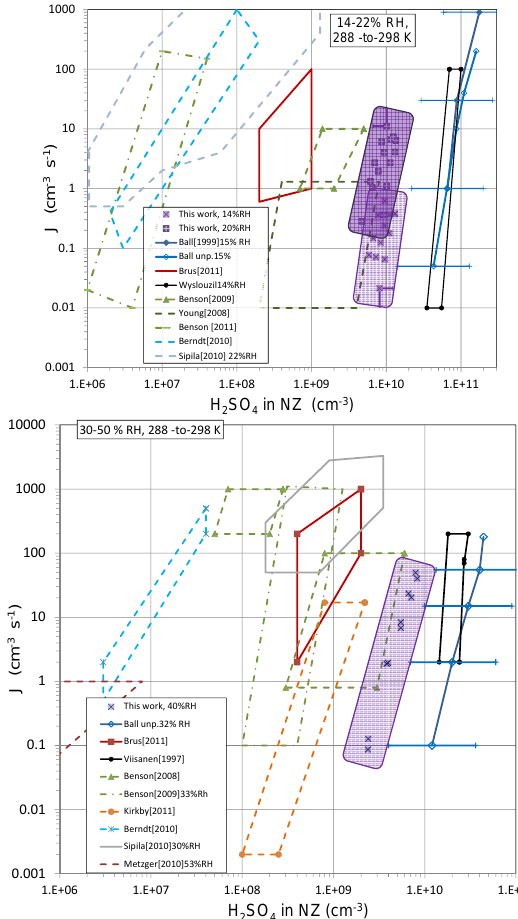
Fig. 6. Comparison of results from this work (purple + and X ) to previous work at relative humidities of (a) ∼ 16% and (b) ∼ 40% where nucleation rate J is plotted against H 2 SO 4 concentration. Those studies with solid lines are results using H 2 SO 4 vapor from sulfuric acid solutions entrained in a flow of gas (bulk) while those with dashed lines use photo-oxidation of SO 2 as a source of H 2 SO 4 . The reported temperatures for the studies are 298K except 288K for Benson et al. (2008, 2009, 2011) and Young et al. (2008); 292K for Kirkby et al. (2011). Typical error bars due to uncertainties in nucleation zone concentration and residence time are shown for two points in (a) . Note that [H 2 SO 4 ] for the Ball et al. (1999) unpub- lished work shown here was measured with an ion-drift arrange- ment similar to that used here and a factor of 10 (+200/ − 66%) was applied to get [H 2 SO 4 ] NZ